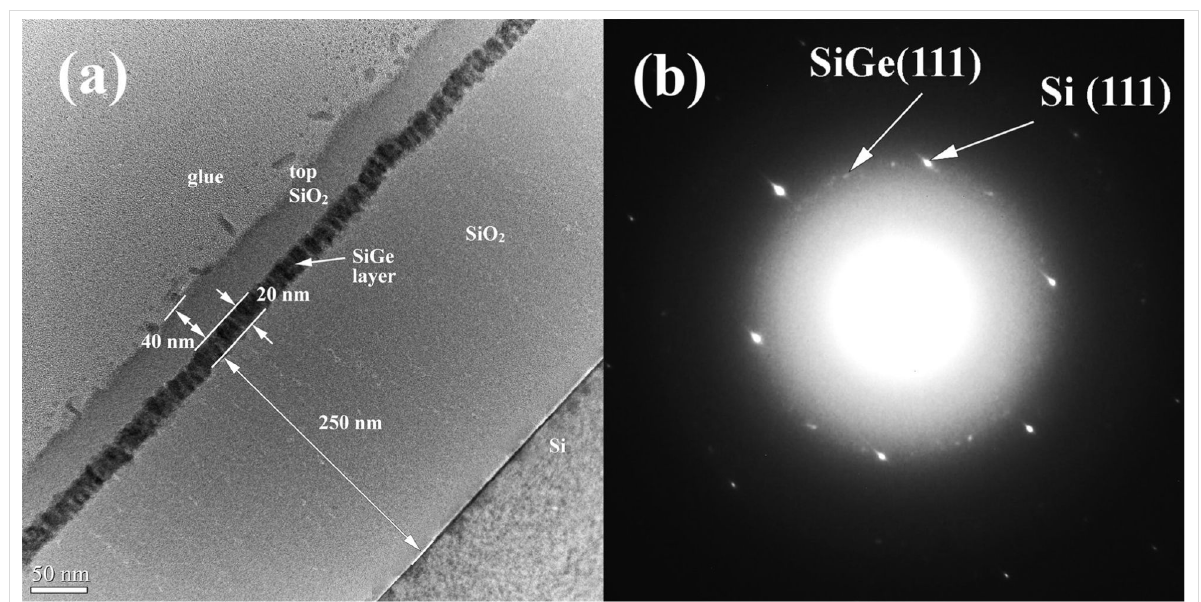
Figure 4: XTEM images of (a) MLs with 20 nm SiGe layer after 600 °C annealing for 1 min, (b) SAED pattern taken on annealed MLs (600 °C, 1 min).